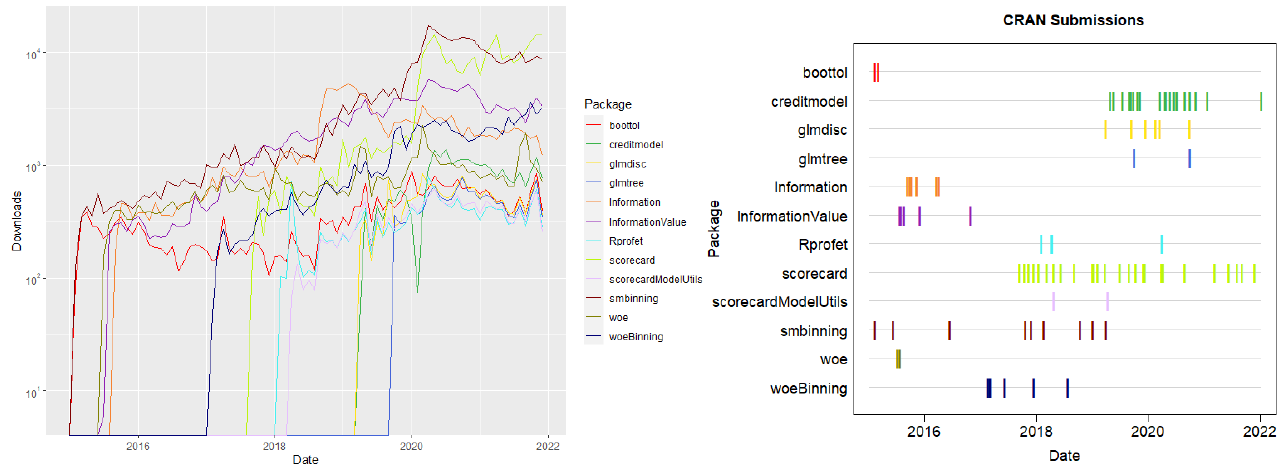
Figure 1. CRAN release activity and download statistics (as returned by cranlogs , Csárdi 2019) of packages available on